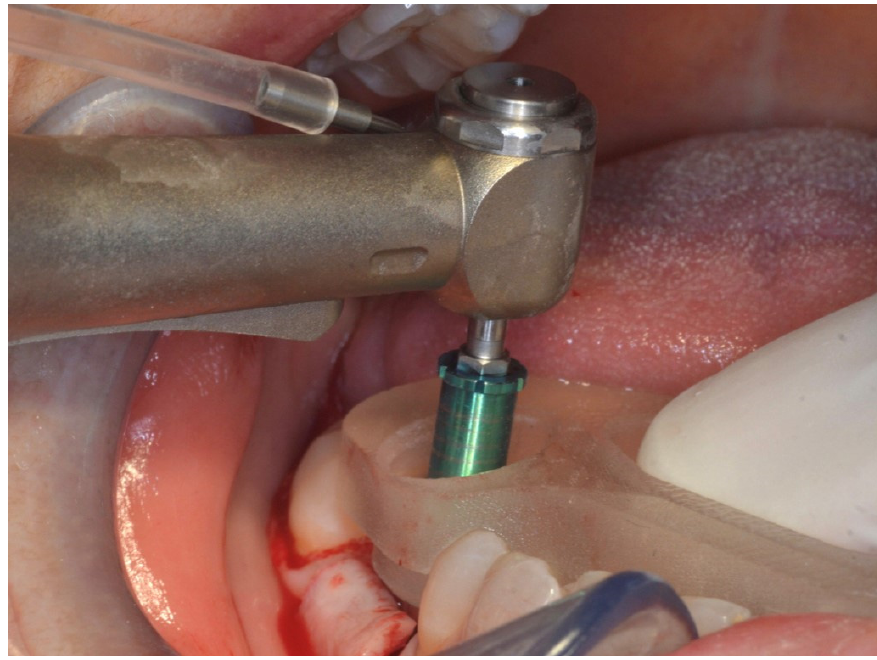
Figure 14. Intraoperative view of the implant fixture during the insertion into the sleeve. After implant site preparation, the fixture was positioned in the digitally planned position and protected with a cover screw (Figure 15). The implant position was verified using standardized periodical radiographs with a paralleling technique.